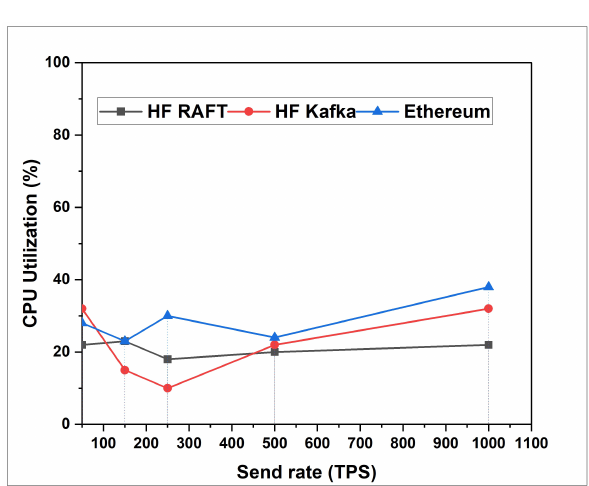
Figure 7. CPU Utilization for